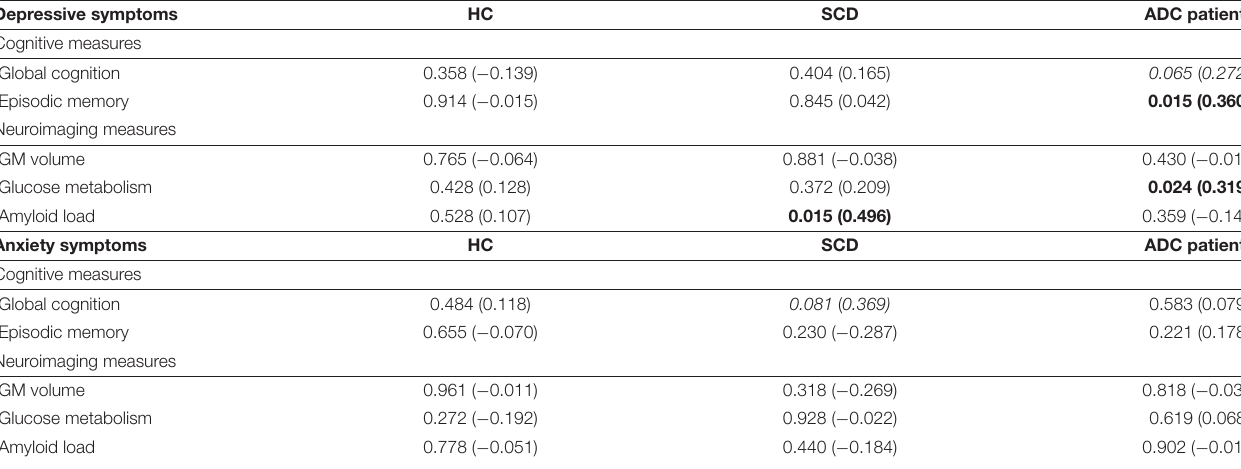
TABLE 2 | Relationships of psychoaffective factors to cognition and neuroimaging measures.